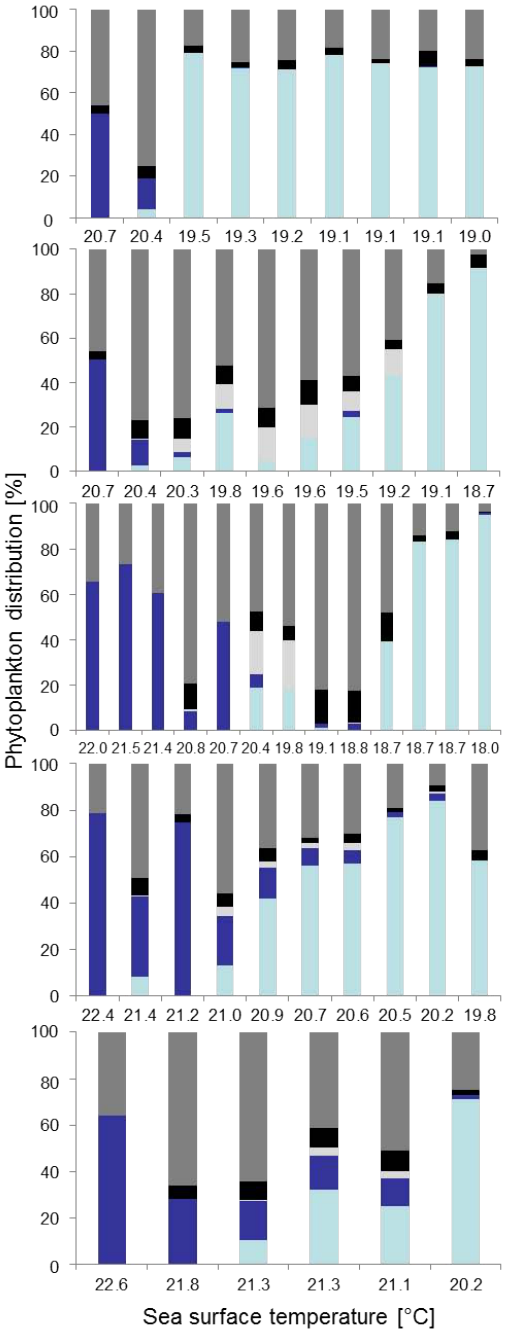
Fig. 3. Phytoplankton distribution in percentage based on their group specific chlorophyll concentration calculated by using the CHEMTAX® program: diatoms (light blue), cyanobacteria (dark blue), dinoflagellates (light grey), haptophytes (black) and other groups (including cryptophytes, chlorophytes, pelagophytes, dark grey) in 5m depth along onshore-offshore transects between 16 ◦ (lowest panel) and 20 ◦ N (upper